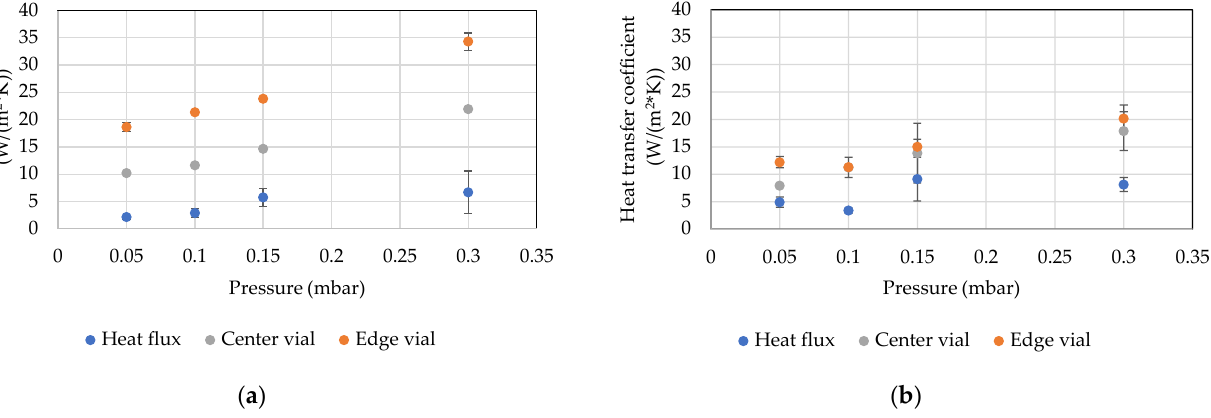
Figure 16. Heat transfer coefficients for different process conditions and vials ( a ) −25 °C ( b ) 0 °C.